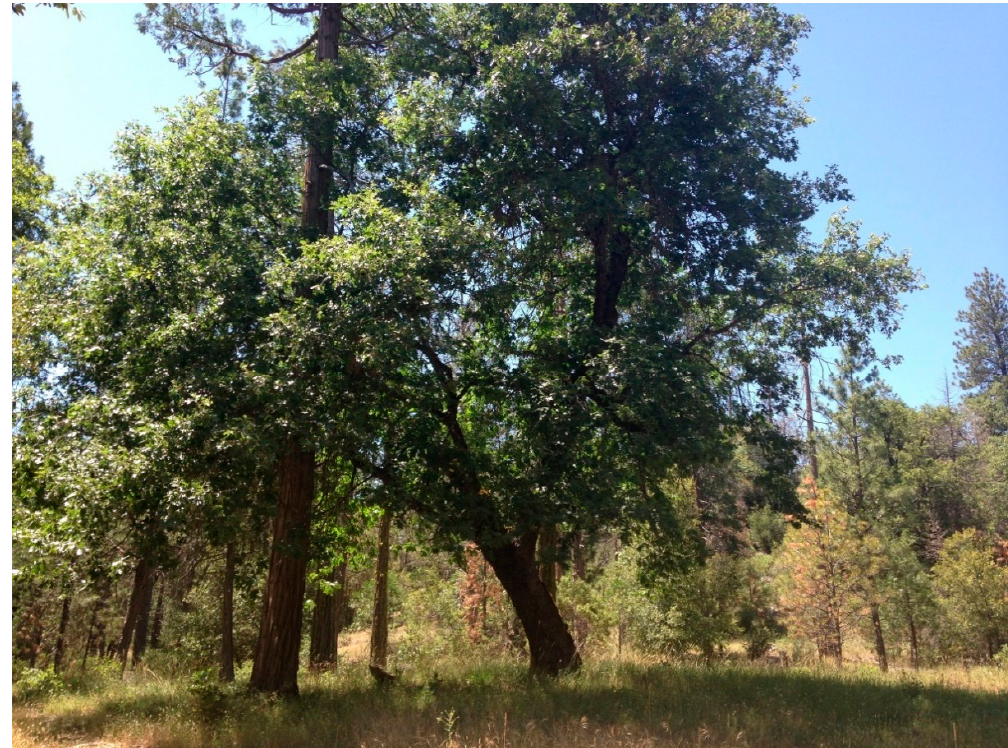
Figure 1. The North Fork Mono Tribe has been using thinning, burning, and other treatments to restore meadows with large California black oaks on the Sierra National Forest, and to promote desired qualities including low, broad crowns to facilitate the production and gathering of acorns (Photo credit: Ron Goode).